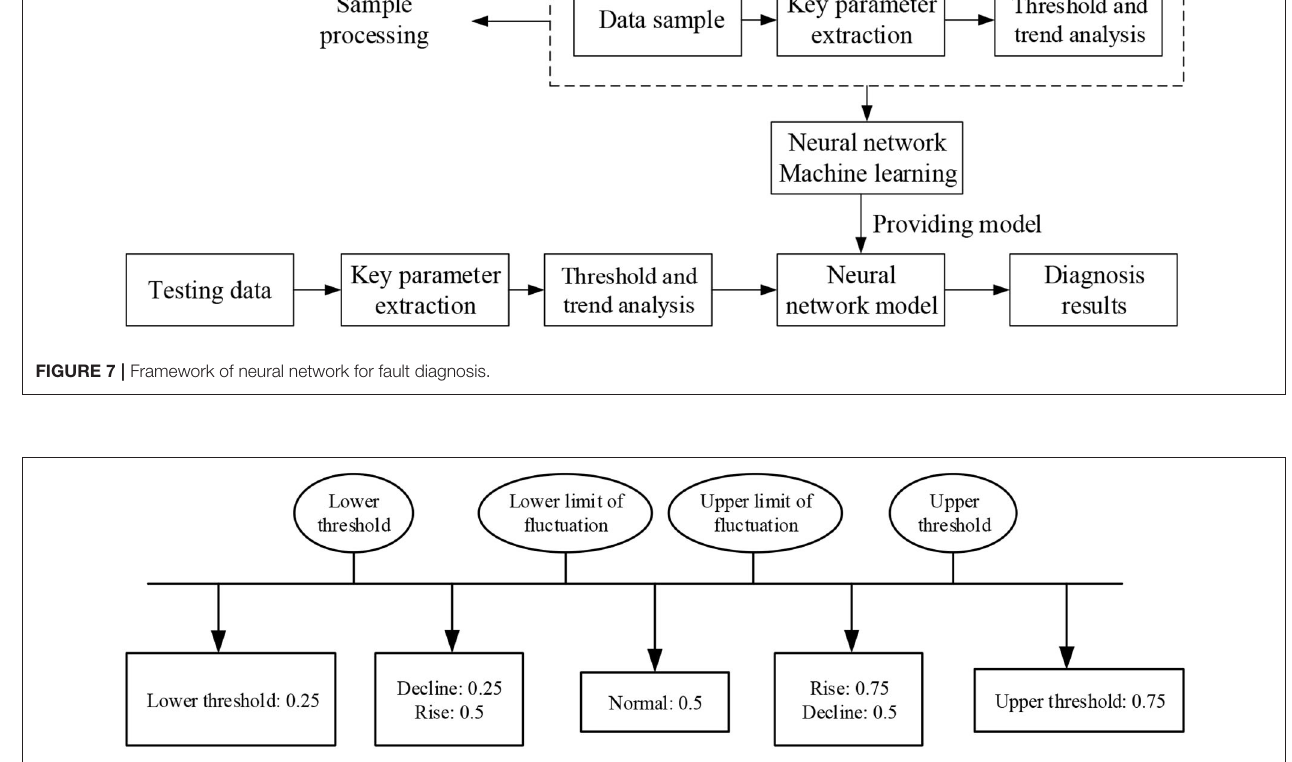
FIGURE 8 | Parameter status division and representation.